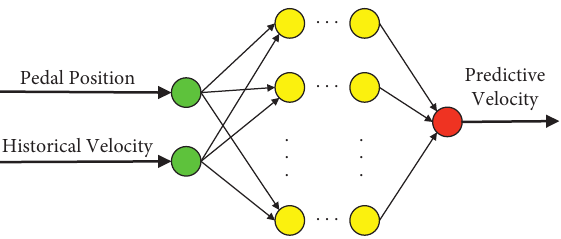
Figure 10: Single basic predictor scheme.